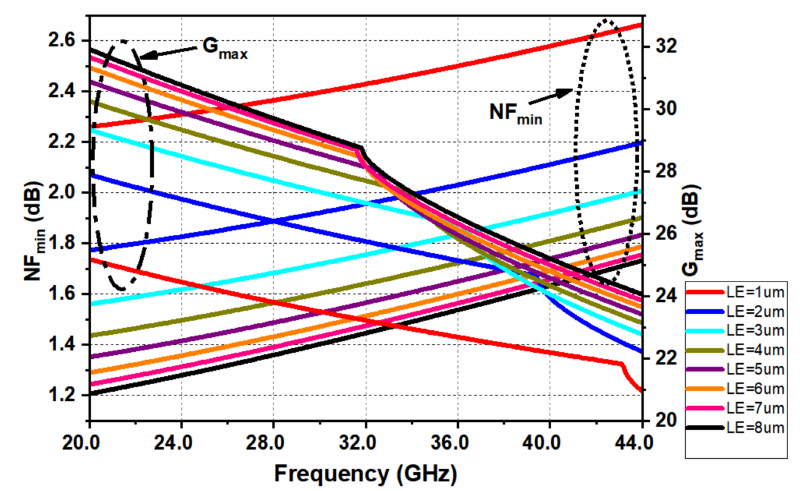
Figure 7. NF min and G max for a CE CBEBC HBT with emitter inductive